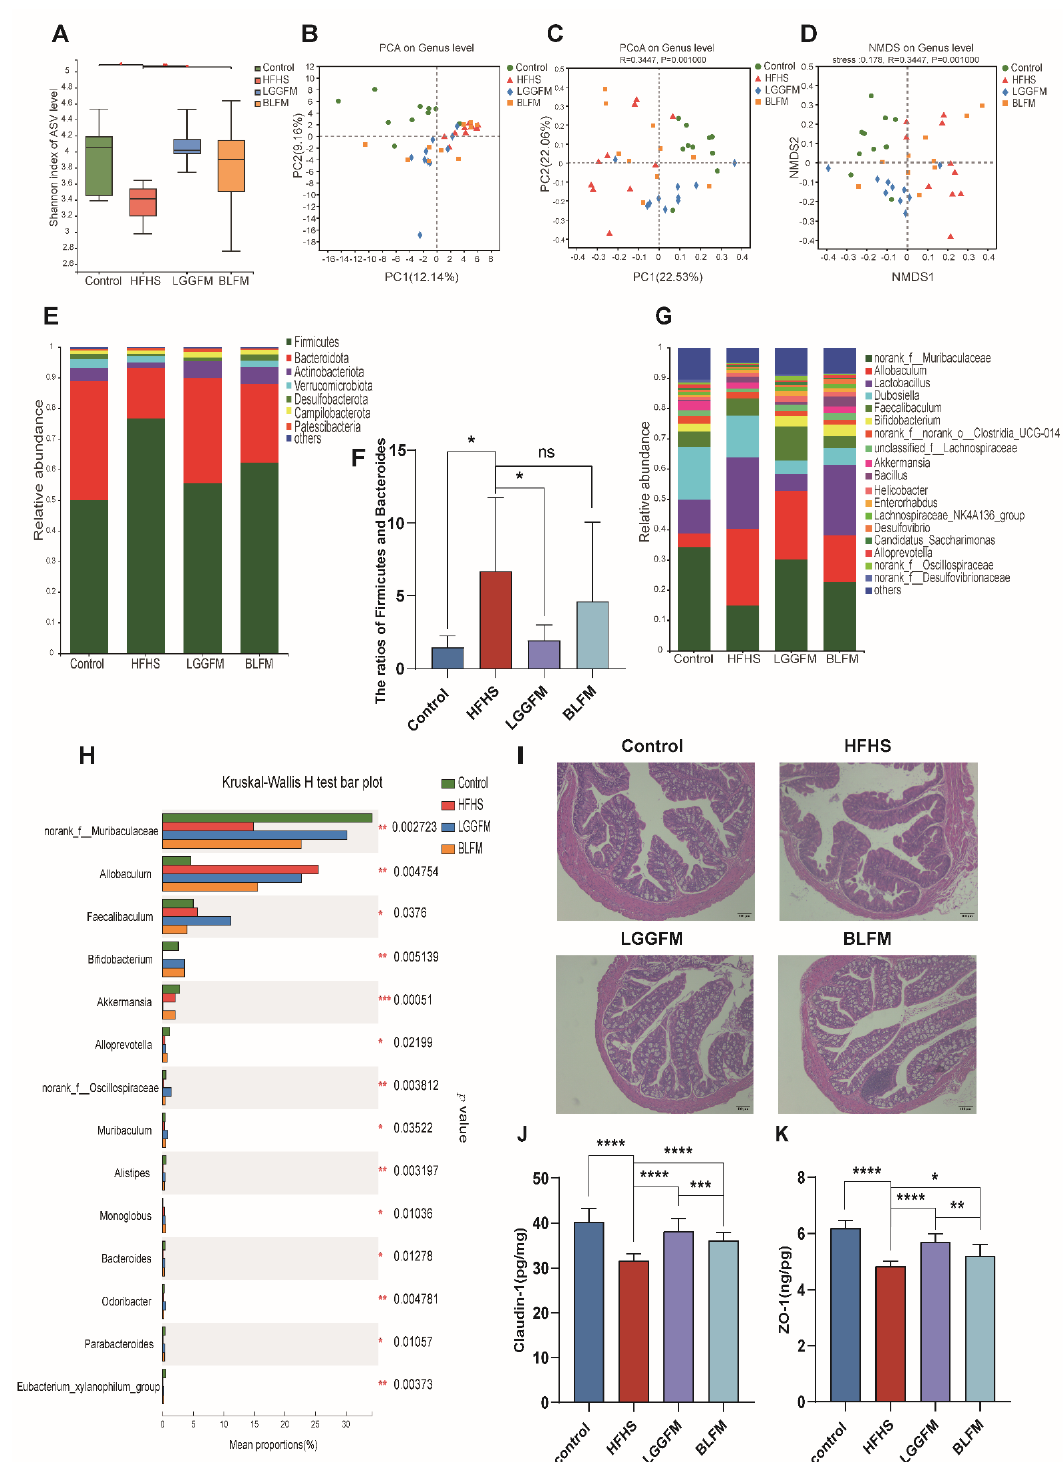
Figure 4. FM modulates the gut microbiota: ( A ) Shannon index, ( B – D ) Plots of PCoA, NMDS, and PCA scores based on the Bray-Curties distance algorithm, ( E ) Relative abundance of gut microbiota at the phylum level, ( F ) Ratio of Firmicutes to Bacteroidetes, ( G ) Relative abundance of gut microbiota at the genus level, ( H ) Relative abundance of bacterial communities at the genus level among different groups, ( I ) H&E of colon tissue sections, ( J ) The content of Claudin-1 in the colon, ( K ) The content of ZO-1 in the colon. Data are presented as means ± SD (n = 10) and analyzed using one-way ANOVA (ns, not significant, * p < 0.05, ** p < 0.01, *** p < 0.001, **** p <